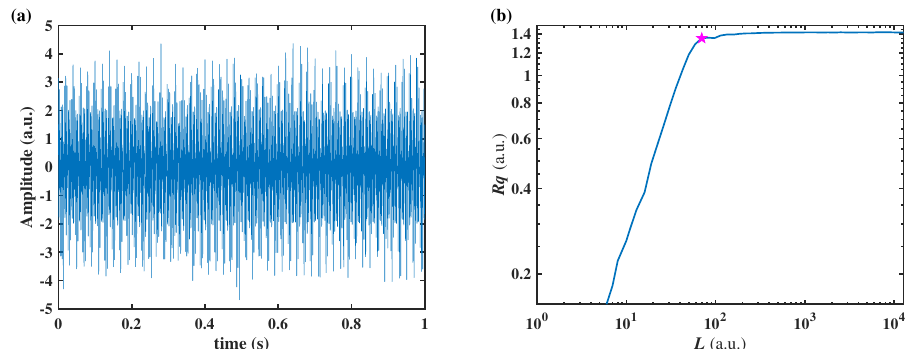
Figure 13. ( a ) The acceleration signal of 1s stable milling, ( b ) the Rq - L curve of the acceleration signal and the star is the position of corner.